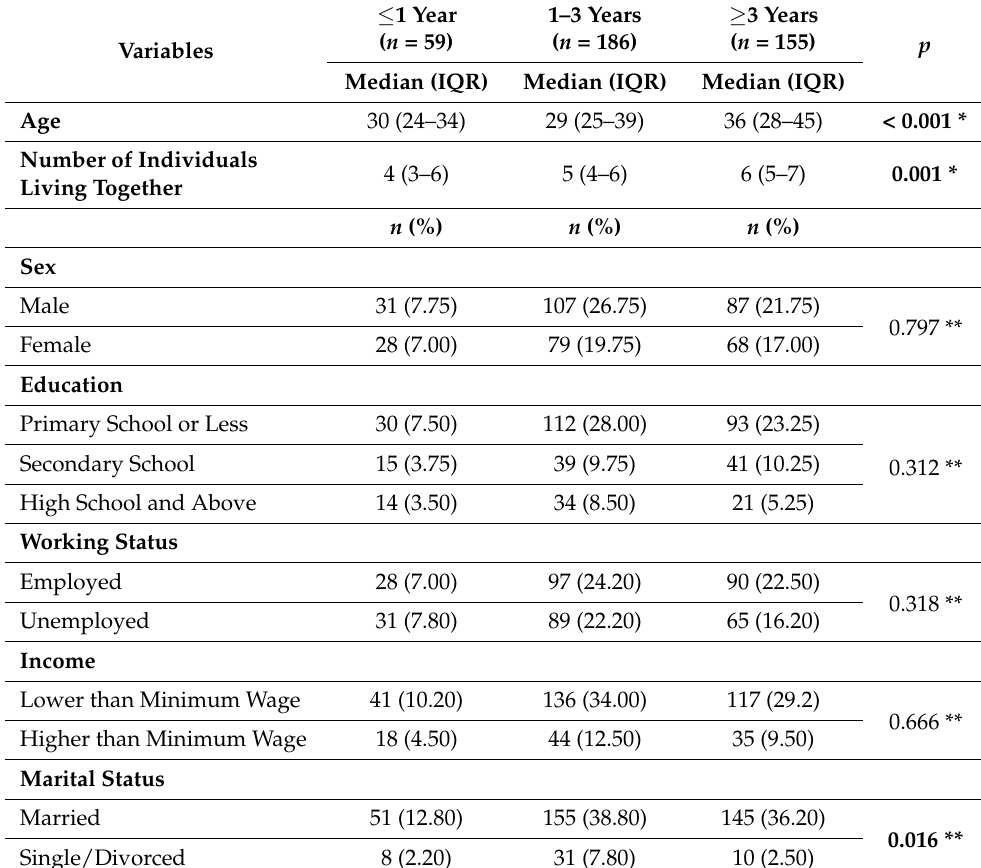
Table 1. Socio-demographic characteristics according to the time spent as refugees.